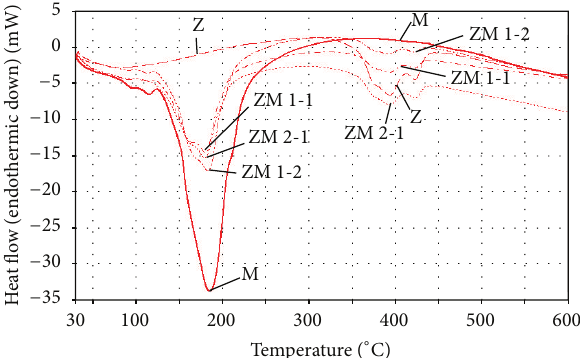
Figure 9: DSC of the synthesised optimum phases of the magne- sium and zinc borates and mixtures of the magnesium and zinc